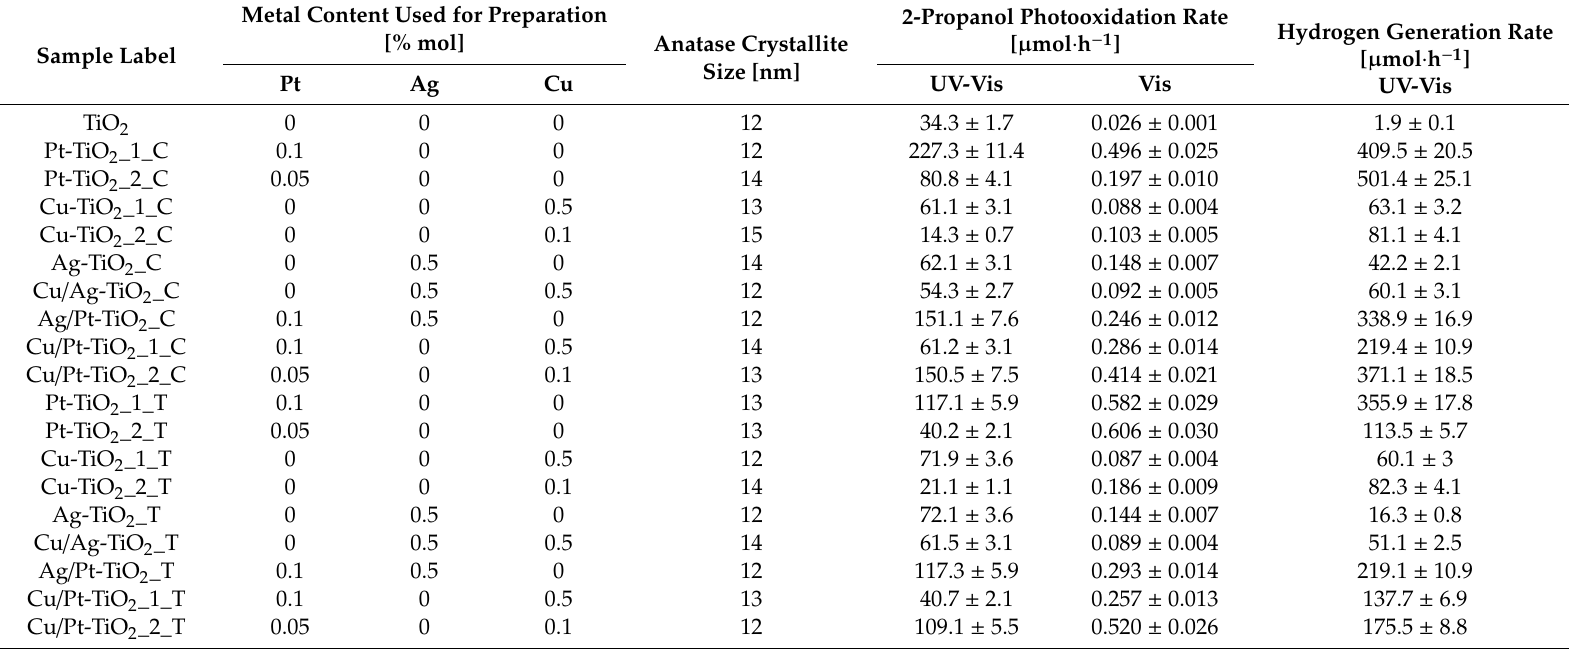
Table 1. Characteristic of physicochemical properties and photocatalytic activity of as-prepared